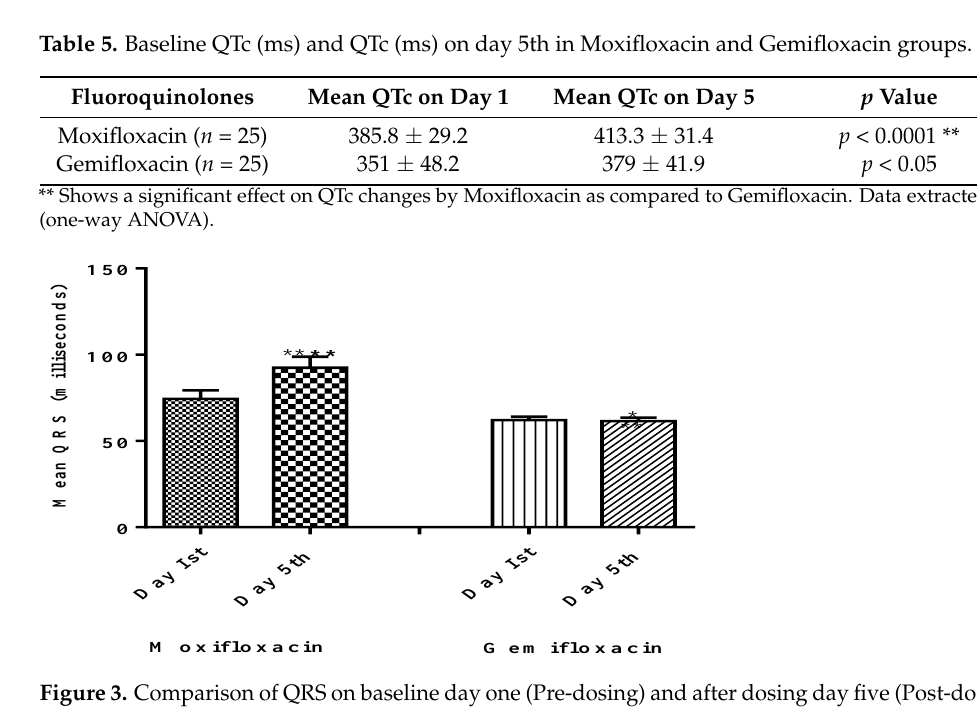
Table 6. Adverse Drugs reactions noted during the clinical